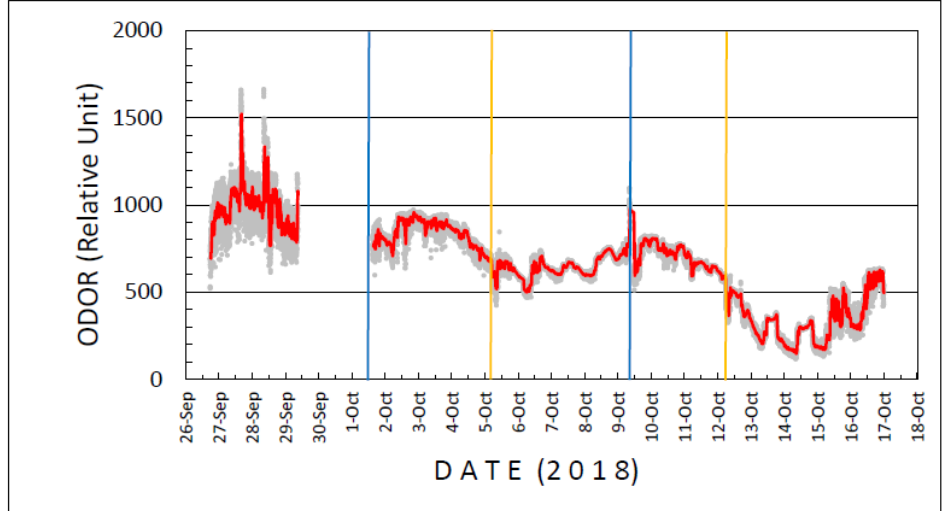
Figure 5. Changes in odor near the container of in-use soluble-type cutting fluid (S-CF). Monitoring was performed at 1-min intervals (gray spots), and data are shown in relative units as average values of every 30 determinations (red line). Blue and orange vertical lines show times when bubbling with microbubbles was started and stopped, respectively.